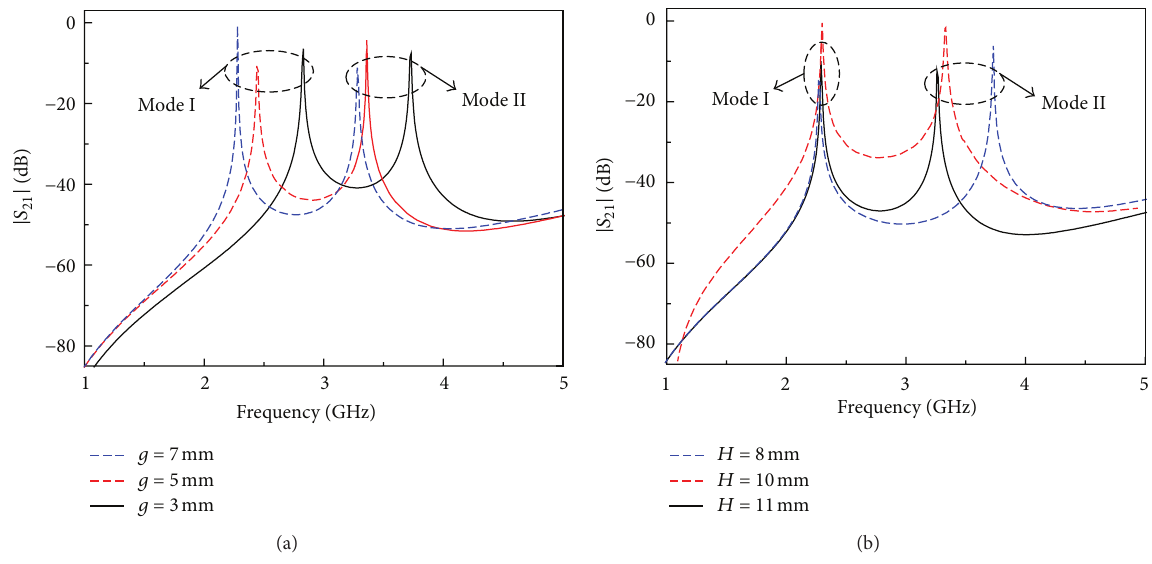
Figure 2: Variation of two resonant modes of DSLR with different physical length: (a) gap width ( 𝐿 1 = 14mm, 𝐿 2 = 10mm, H = 10.3 mm, and 𝑤 1 = 0.5 mm) and (b) stub height ( 𝐿 1 = 14mm, 𝐿 2 = 10mm, 𝑔 = 5 mm, and 𝑤 1 = 0.5